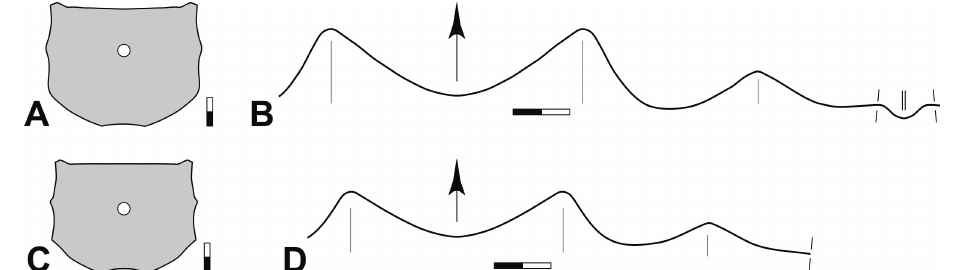
Fig. 12. Stroboceras ancilis sp. nov. from Timimoun (both Korn et al . 2002 Coll.). A . Whorl profile of holotype MB.C.30459.1. B . Suture line of holotype MB.C.30459.1, at ww = 11.6 mm, wh = 8.8 mm. C . Whorl profile of paratype MB.C.30459.2. D . Suture line of paratype MB.C.30459.2, at ww = 10.4 mm, wh = 7.1 mm. Scale bar units = 1